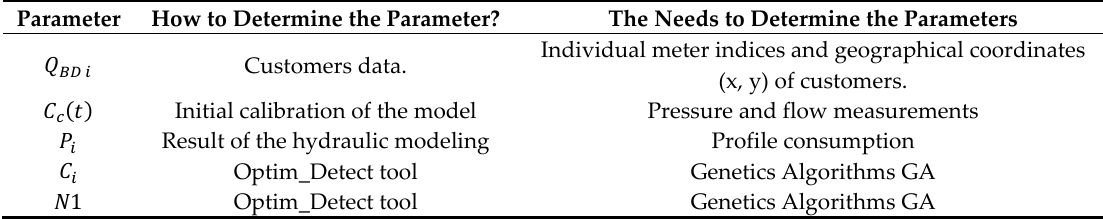
Table 1. Parameter determination (consumption and